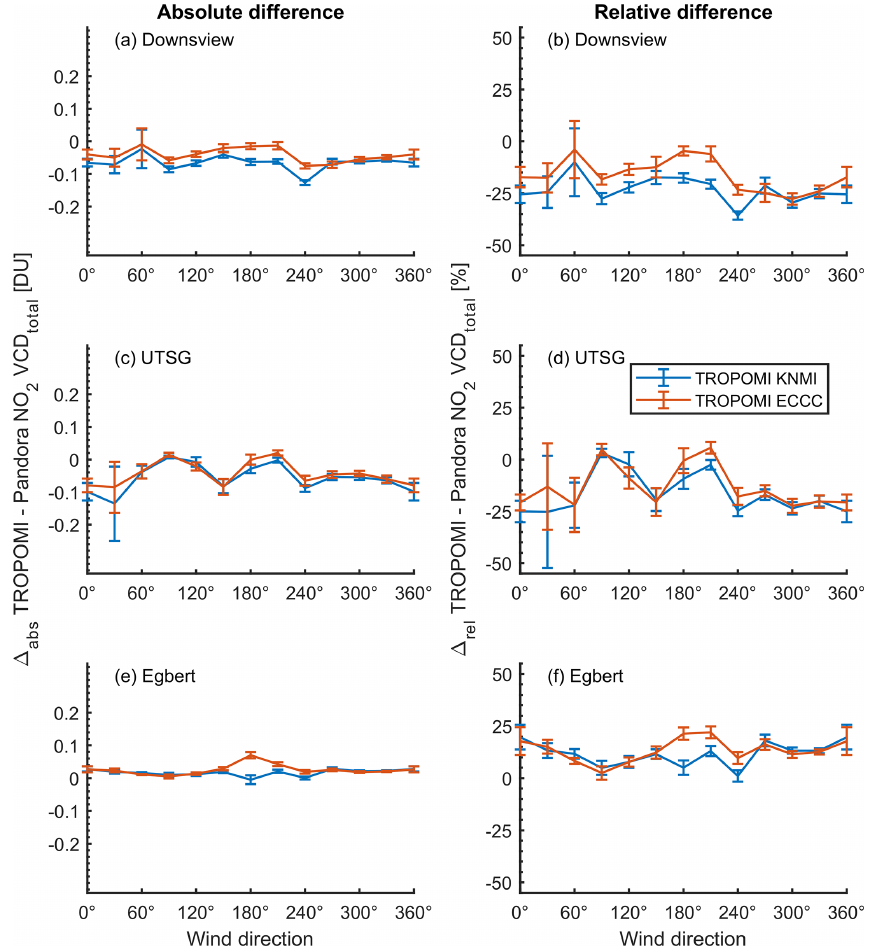
Figure 7. The absolute and relative differences between TROPOMI and Pandora coincident measurements from three sites, binned by wind direction. TROPOMI and Pandora absolute differences are shown in (a) , (c) , and (e) ; their relative differences are shown in (b) , (d) , and (f) . Blue lines are differences calculated using TROPOMI KNMI data products, and red lines are their counterparts using ECCC data products. Error bars are the standard error of the